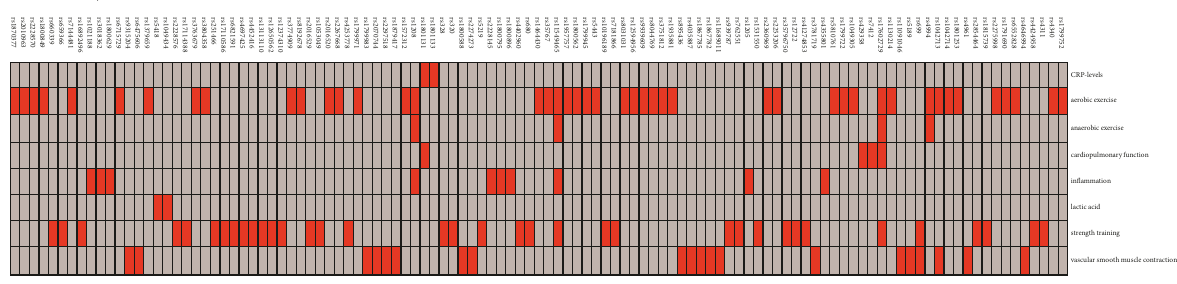
Figure 1: Heatmap of 111 SNP. Table 1: Regional distribution of 45 SNP